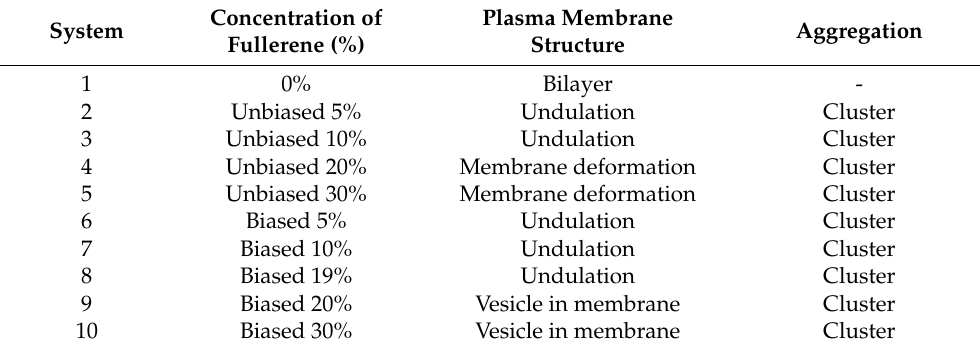
Figure 1. ( a ) The distribution of lipid tail unsaturation in the inner and outer leaflets of a plasma membrane. The lipid compositions are reported in Table S3. Snapshots from an unbiased simulation at 10% fullerene concentration ( b ) at the beginning (0 µs) and ( c ) after 10 µs. Fullerenes are shown in red, phosphate groups in purple, and cholesterols in yellow. Lipids are colored by their headgroups type (PC: green, PE: white, SM: cyan, GM: pink, PS: violet, PIPs: aqua, other: ice blue). Table 1. Summary of membrane structures and aggregation of fullerenes at the end of the simulations.